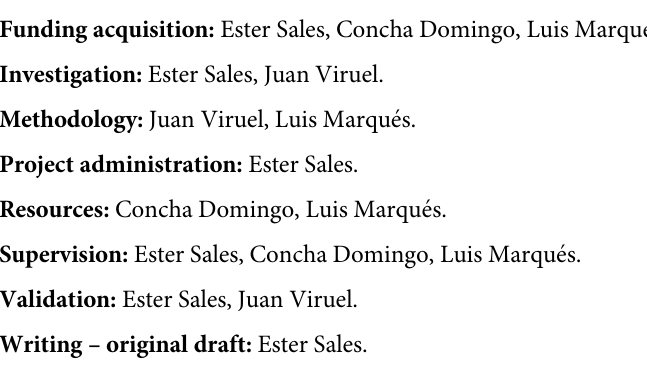
S1 Fig. Manhattan plots for the association between 1672 SNPs markers and coleoptile growth rates V25 (A, E), V15 (B, F), V1514d (C, G) and V153w (D, H) obtained for data of